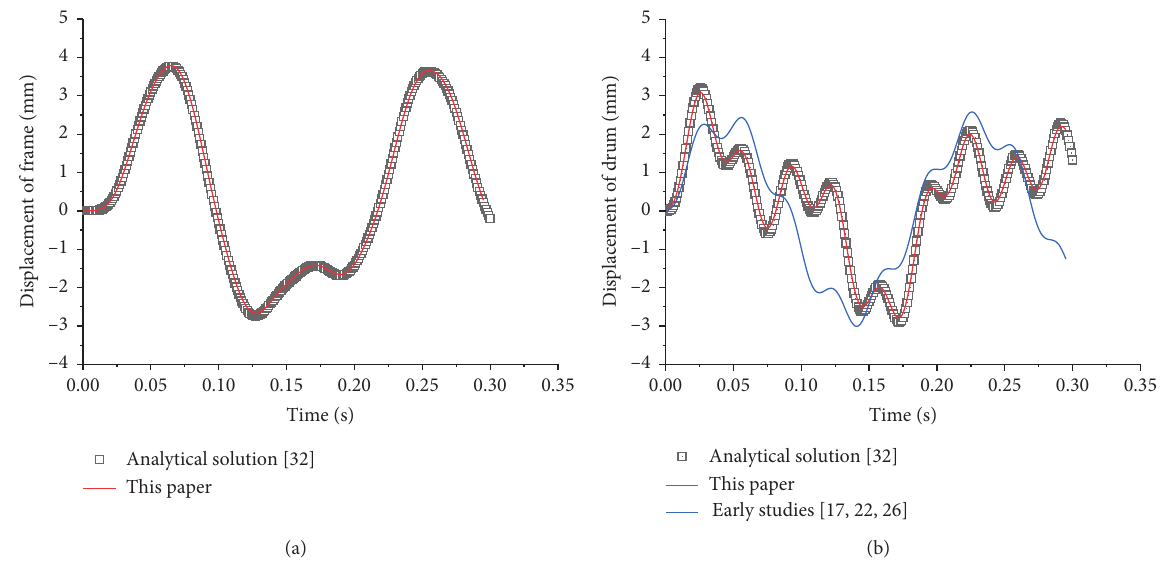
Figure 9: Displacement results of the drum and frame based on numerical simulation and analytical solution. (a) Frame displacement; (b) drum displacement.